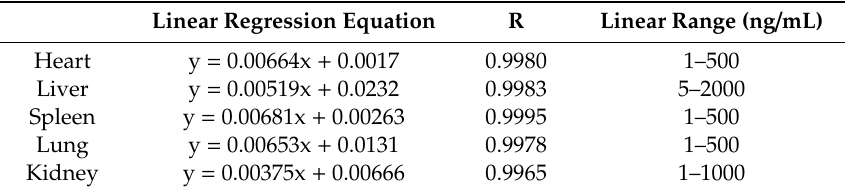
Table 1. Regression data of HCPT in all matrices.